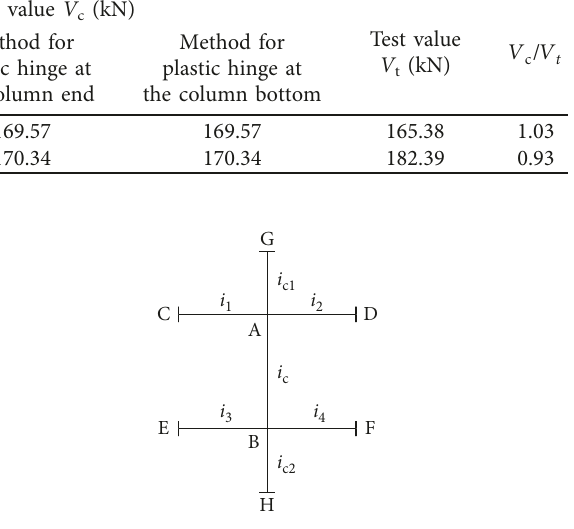
Figure 13: Beam and column with line stiffness. Table 3: Calculated values and test values of initial elastic layer stiffness of RACFST